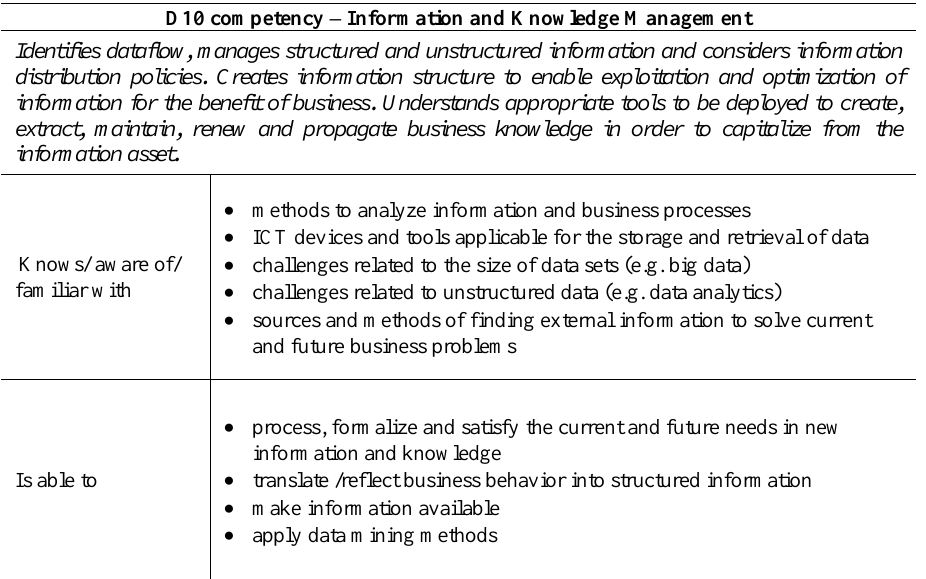
Table 1. Competency map fragment of a leading business information